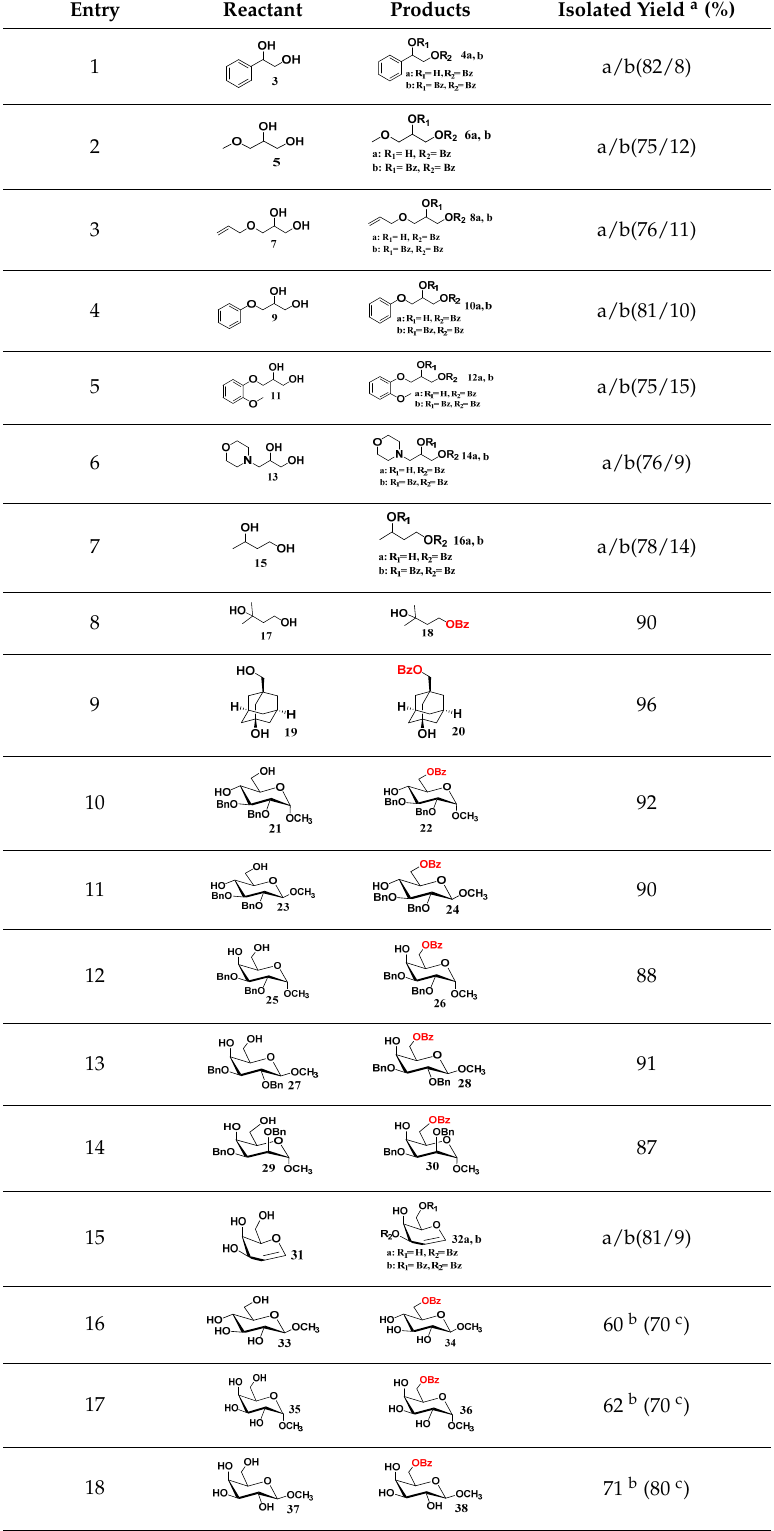
Table 2. 1-Benzoylimidazole used for selective benzoylation of diols and carbohydrates.